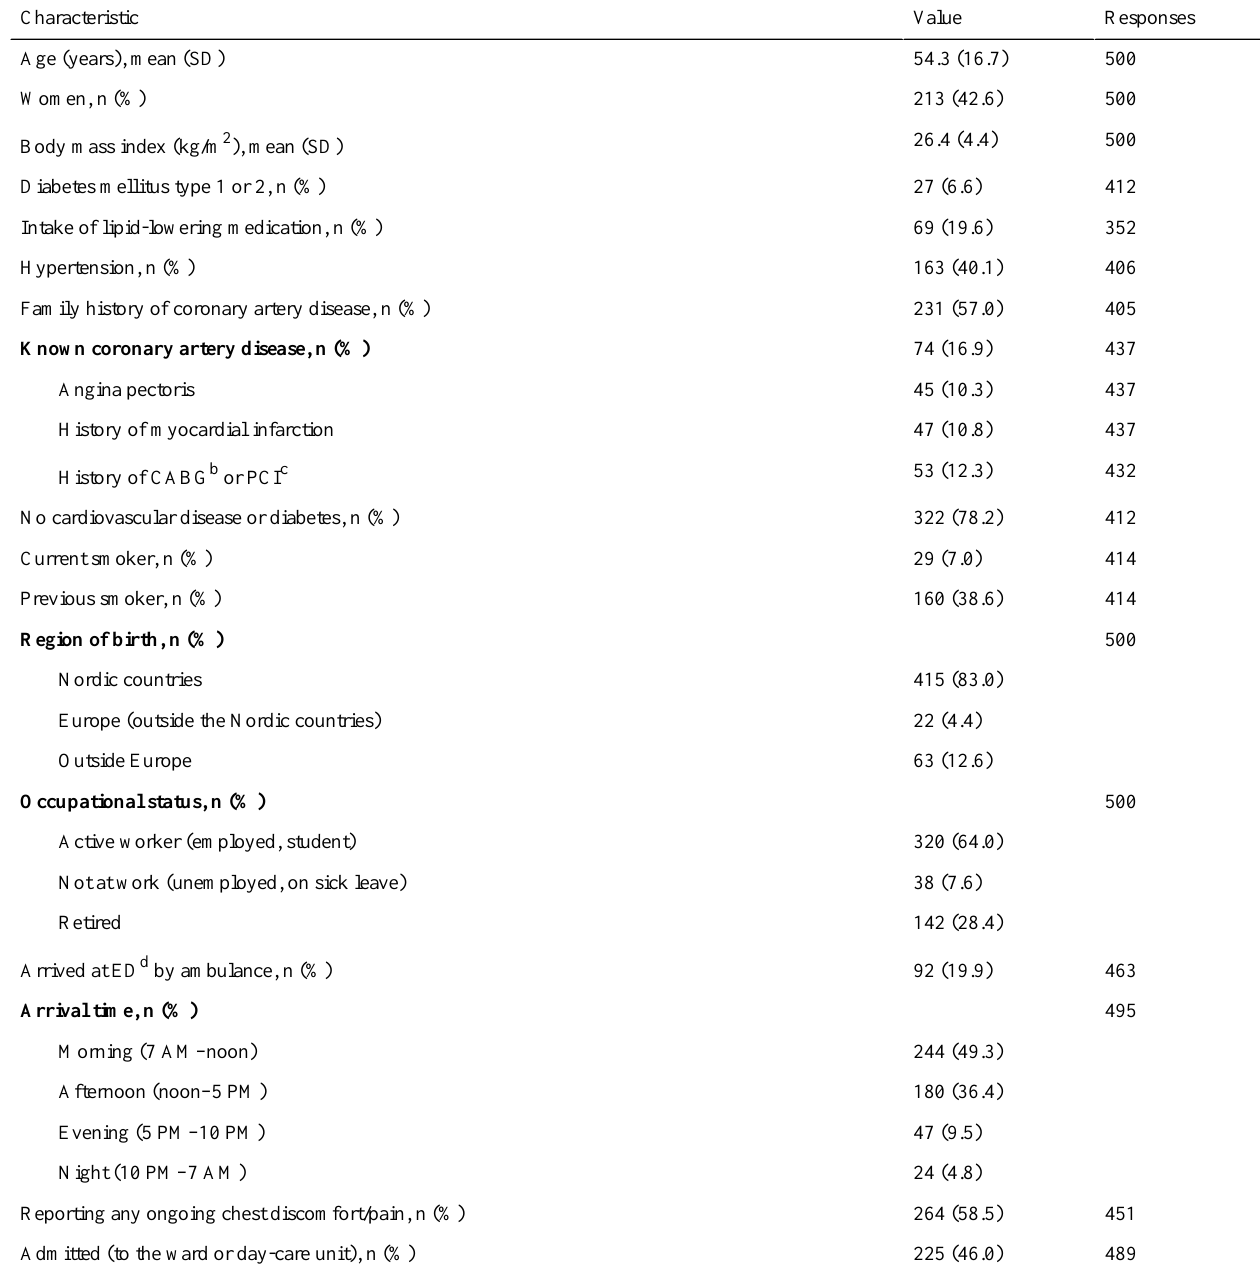
Table 2. Patient baseline characteristics (self-reported). a